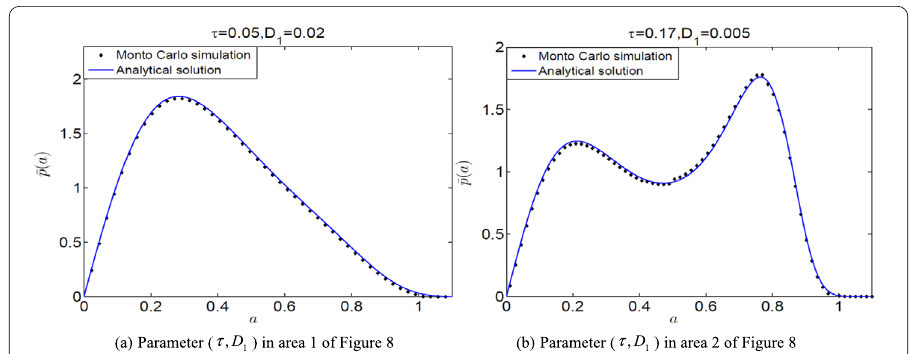
Figure 9 PDFs for ¯ p ( a ) under additive noise excitation (taking τ and D 1 as unfolding parameters)